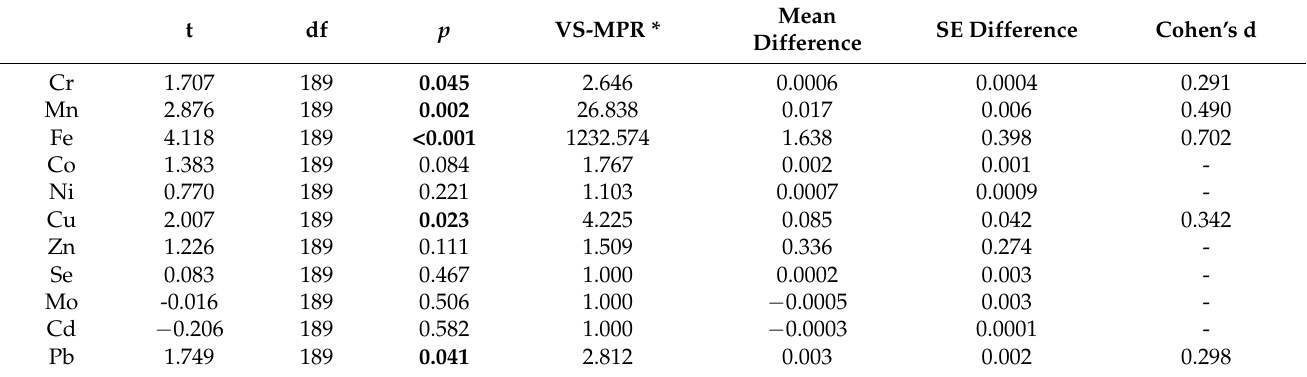
region. ( Fe : Mean Mashavera = 2.493, Mean Khrami = 0.855, t = 4.118, p < 0.01), ( Mn : Mean